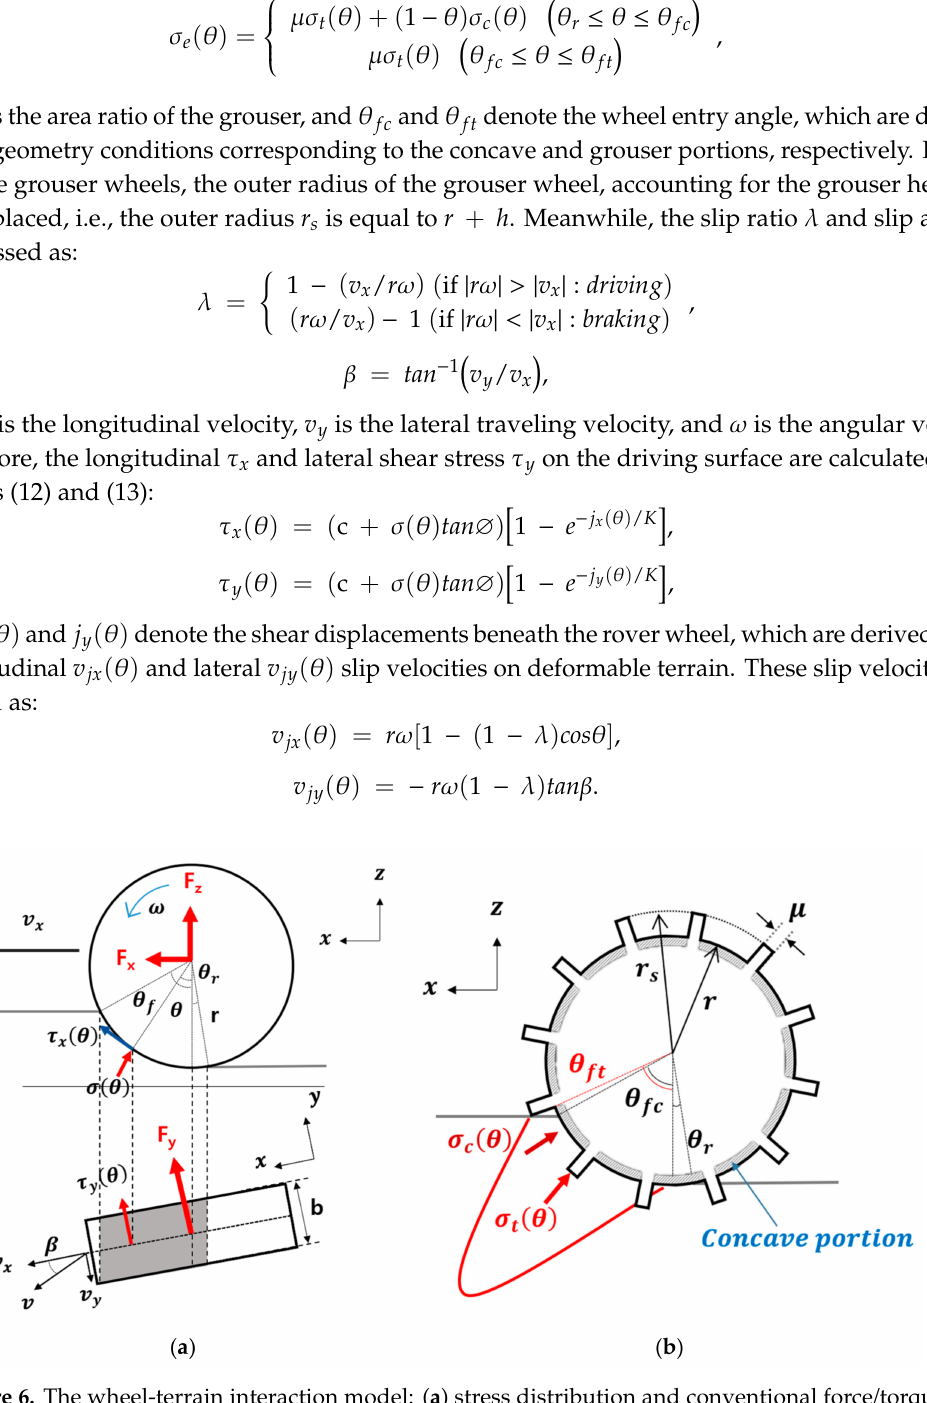
Figure 6. The wheel-terrain interaction model: ( a ) stress distribution and conventional force / torque model of the wheel on deformable terrain; ( b ) model of the grouser wheel on deformable terrain showing the normal stress components at grouser tip and concave